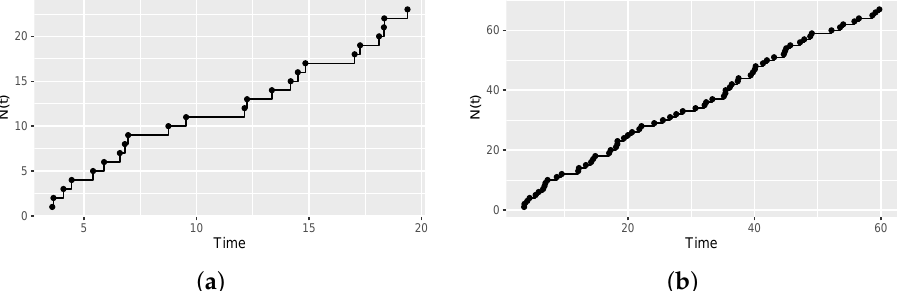
Figure 4. Simulation of a Cox process with Folded Normal intensity function with parameters µ = 0, σ 2 = 9 and with covariance function k Z ( h ) = 9 e − 0,15 | h | for T = 20 ( a ) and T = 60 ( b